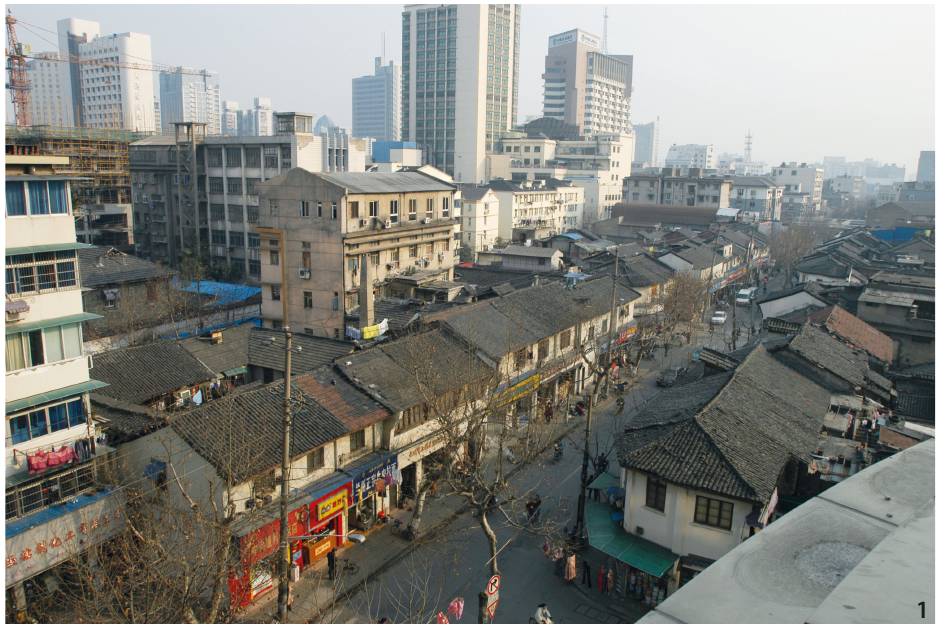
Figure 1 Zhongshan Road before the renovation project (Source: the